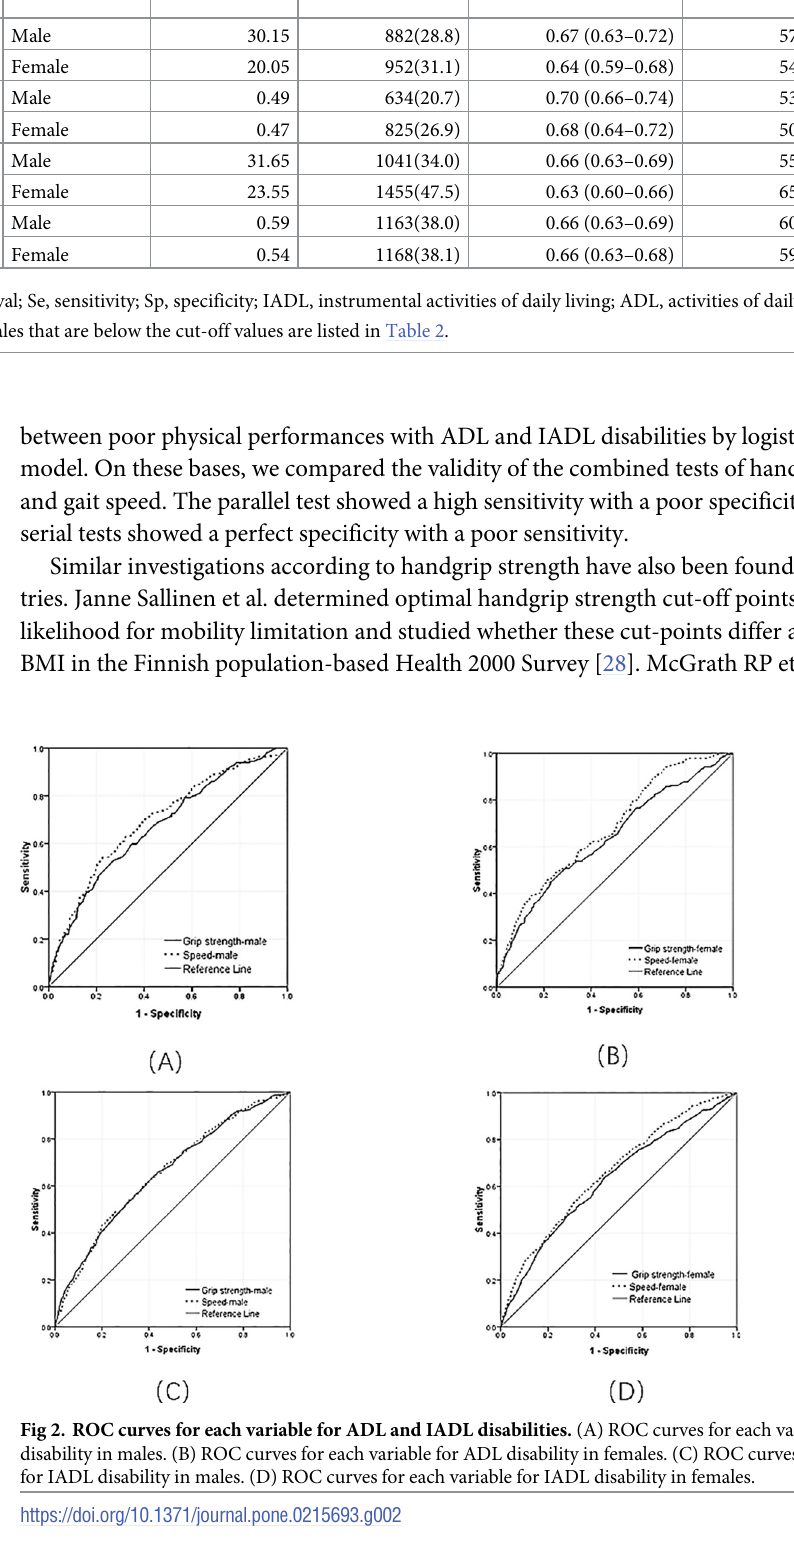
Table 2. Validity of handgrip strength and gait speed for ADL and IADL disabilities according to the ROC analysis for men and women separately. Physical Performance Test